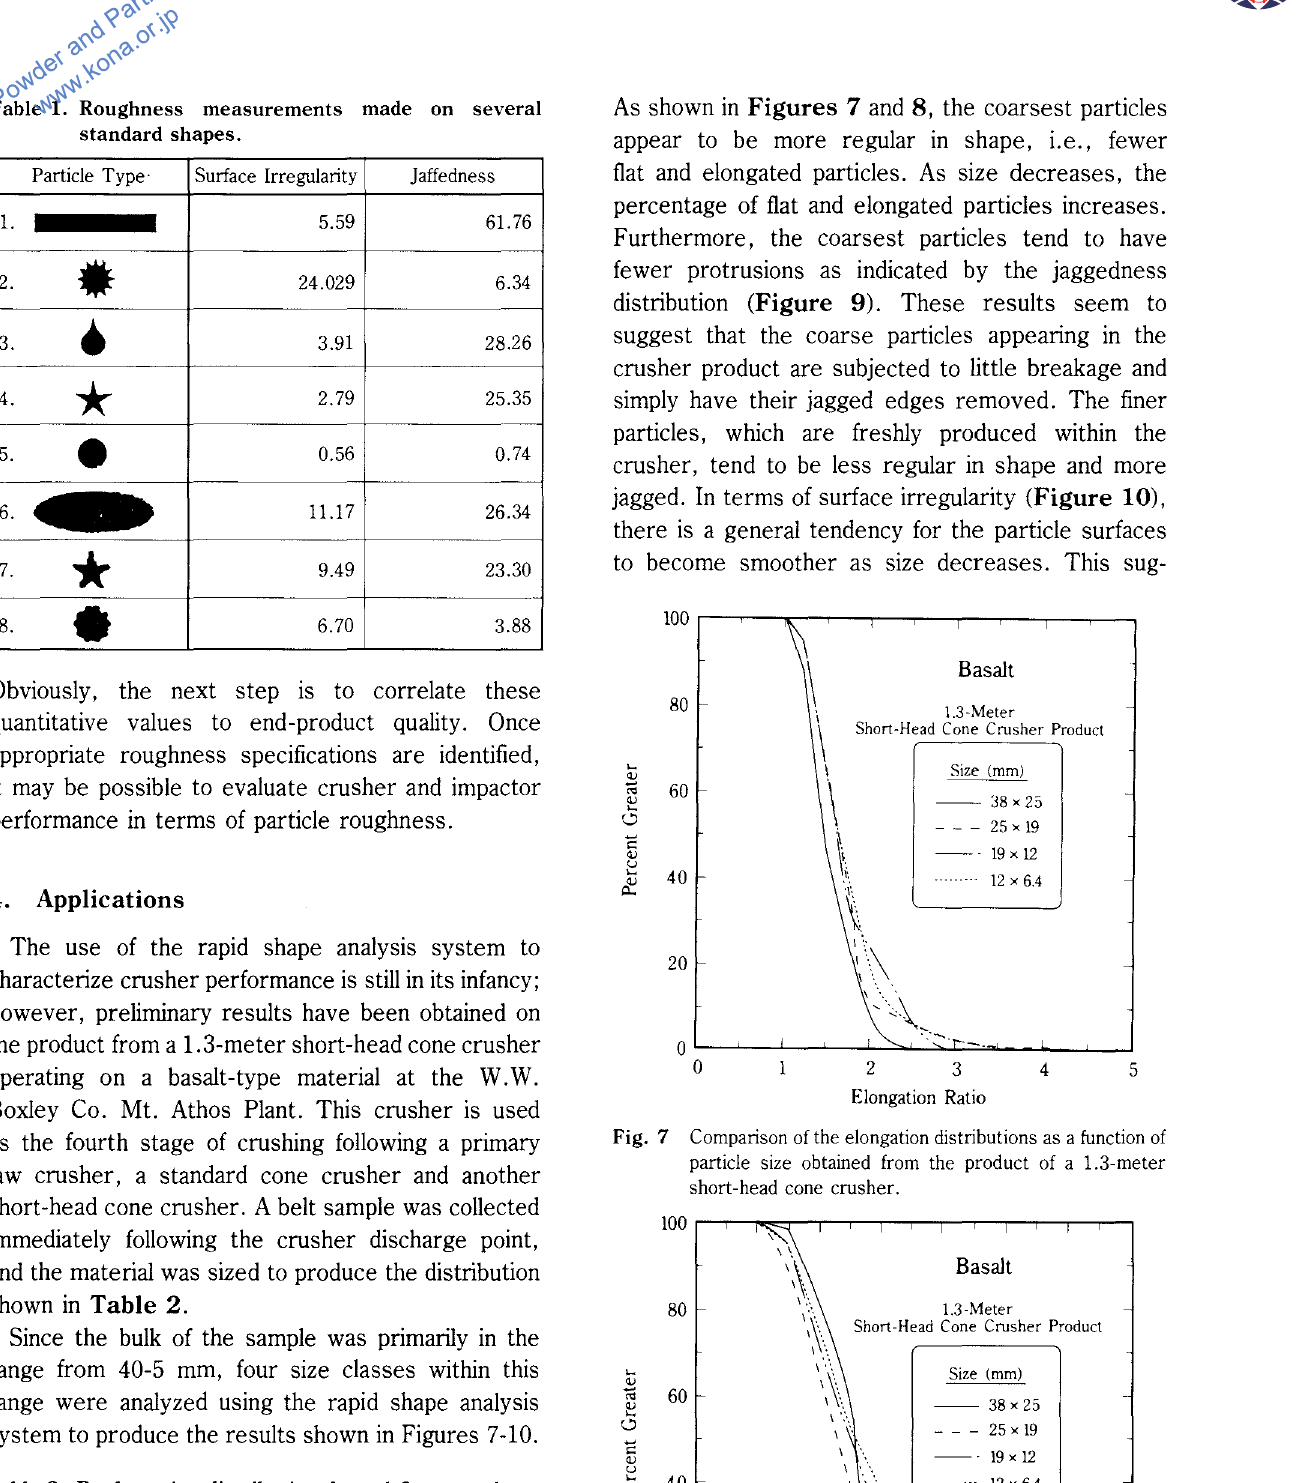
Table 2. Product size distribution from 1.3-meter short head cone crusher.